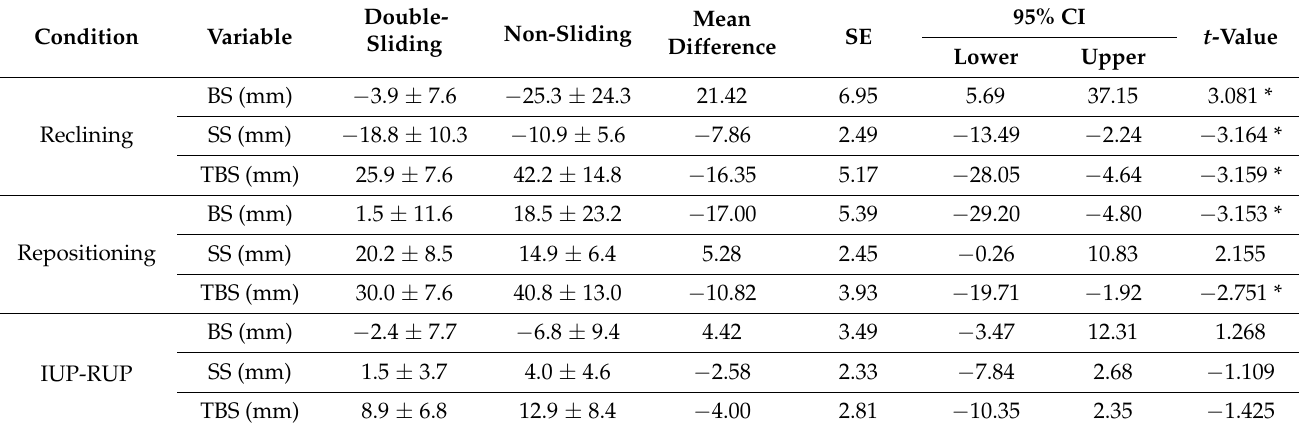
Table 2. Comparison of slip variation between the two conditions (double-sliding versus